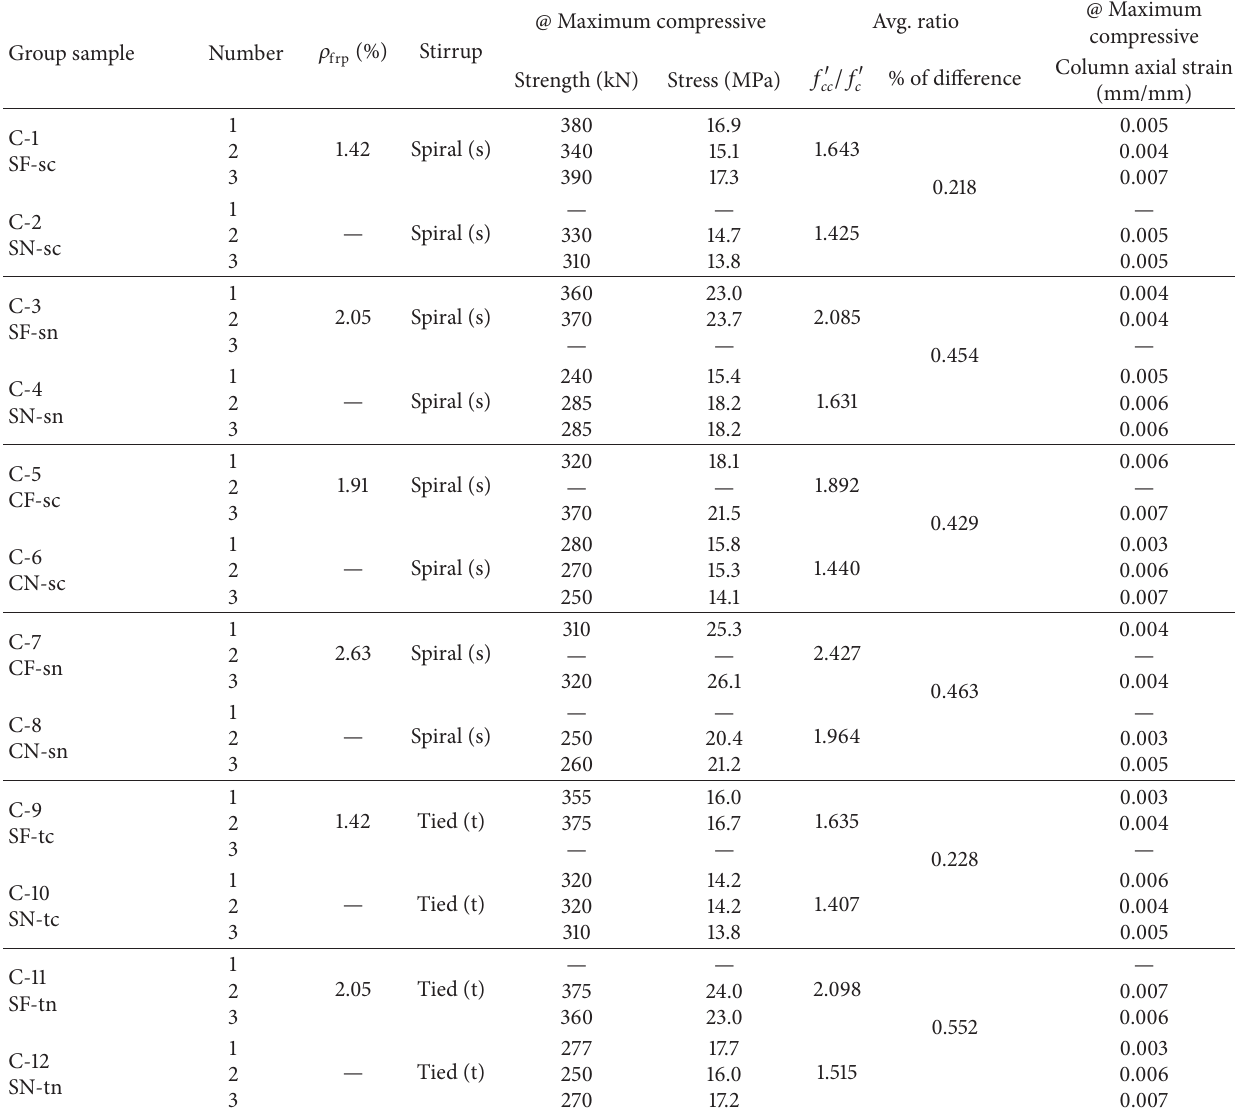
Table 2: Experimental test